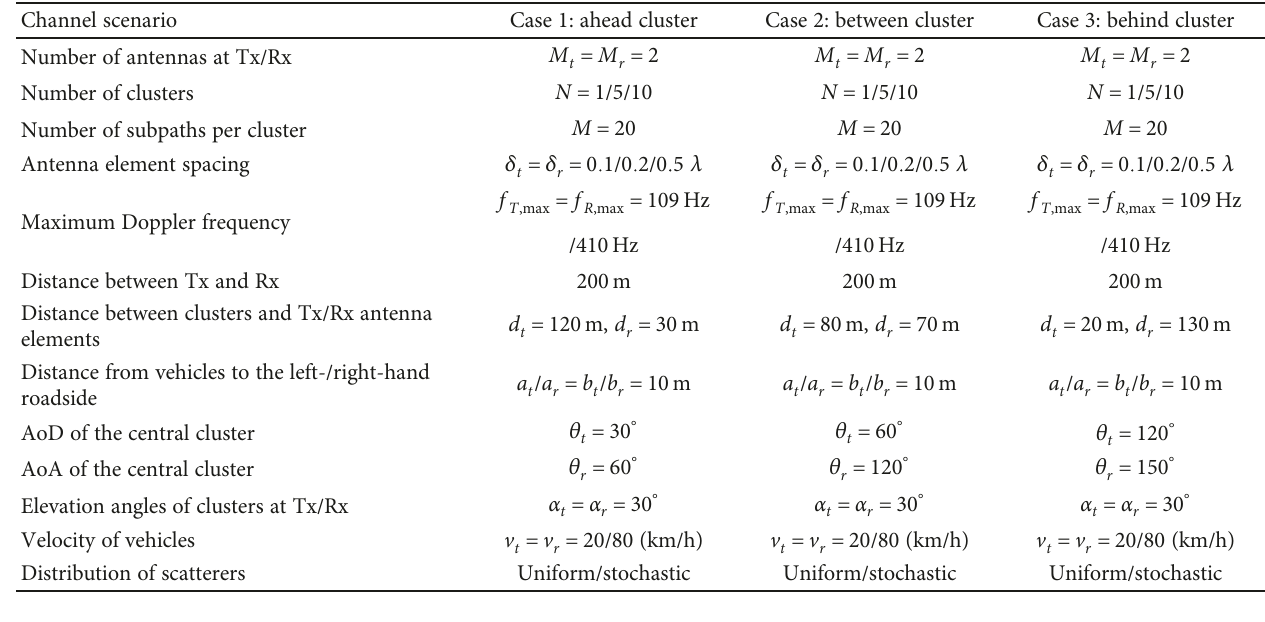
Table 1: Environment parameters.